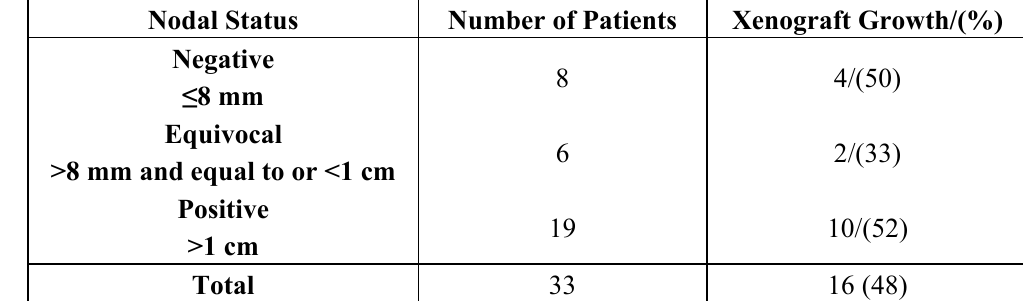
Table 1. Patient nodal status and xenograft growth. There was no correlation between the number of cervix patients with negative, equivocal and positive nodal status with the number of xenografts grafted ( p = 0.78). The total represents the number of biopsies implanted and sub-number of those grafted successfully. The number in brackets shows the